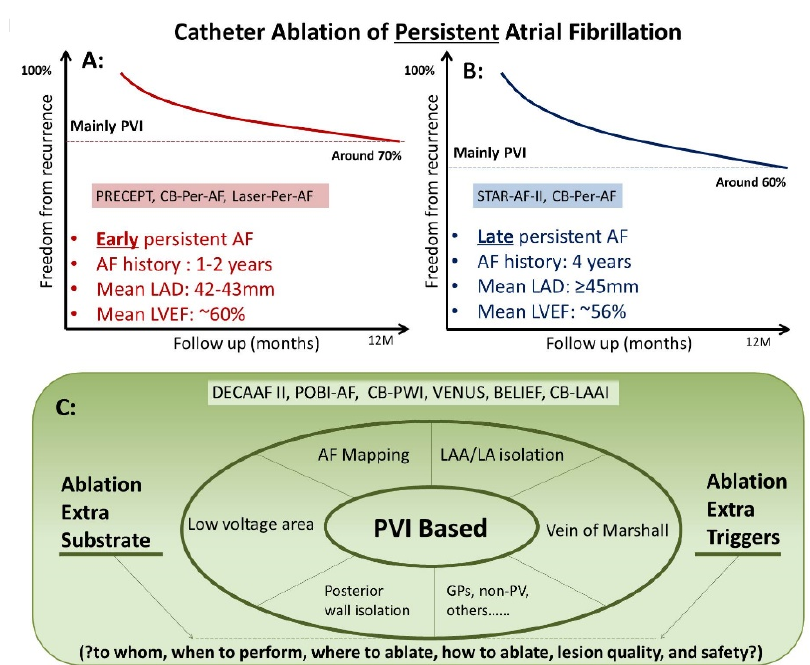
Figure 4. Catheter Ablation of Persistent Atrial Fibrillation. ( A ) Catheter ablation in “early” persistent AF. ( B ) Catheter ablation in “late” persistent AF. ( C ) Catheter ablation in non-PV sites.